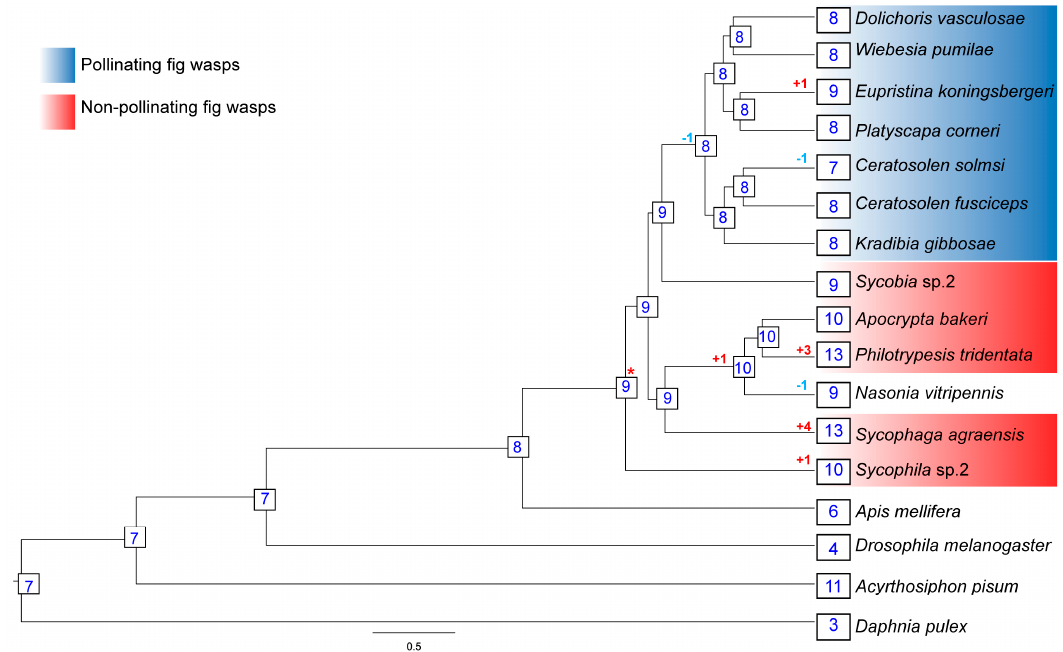
Figure 5. The expansion and contraction of CSP gene family. Numbers on each node are the estimated ancestral copy numbers. The red asterisk represents the number of CSP genes of the most recent common ancestor of the Chalcidoidea.